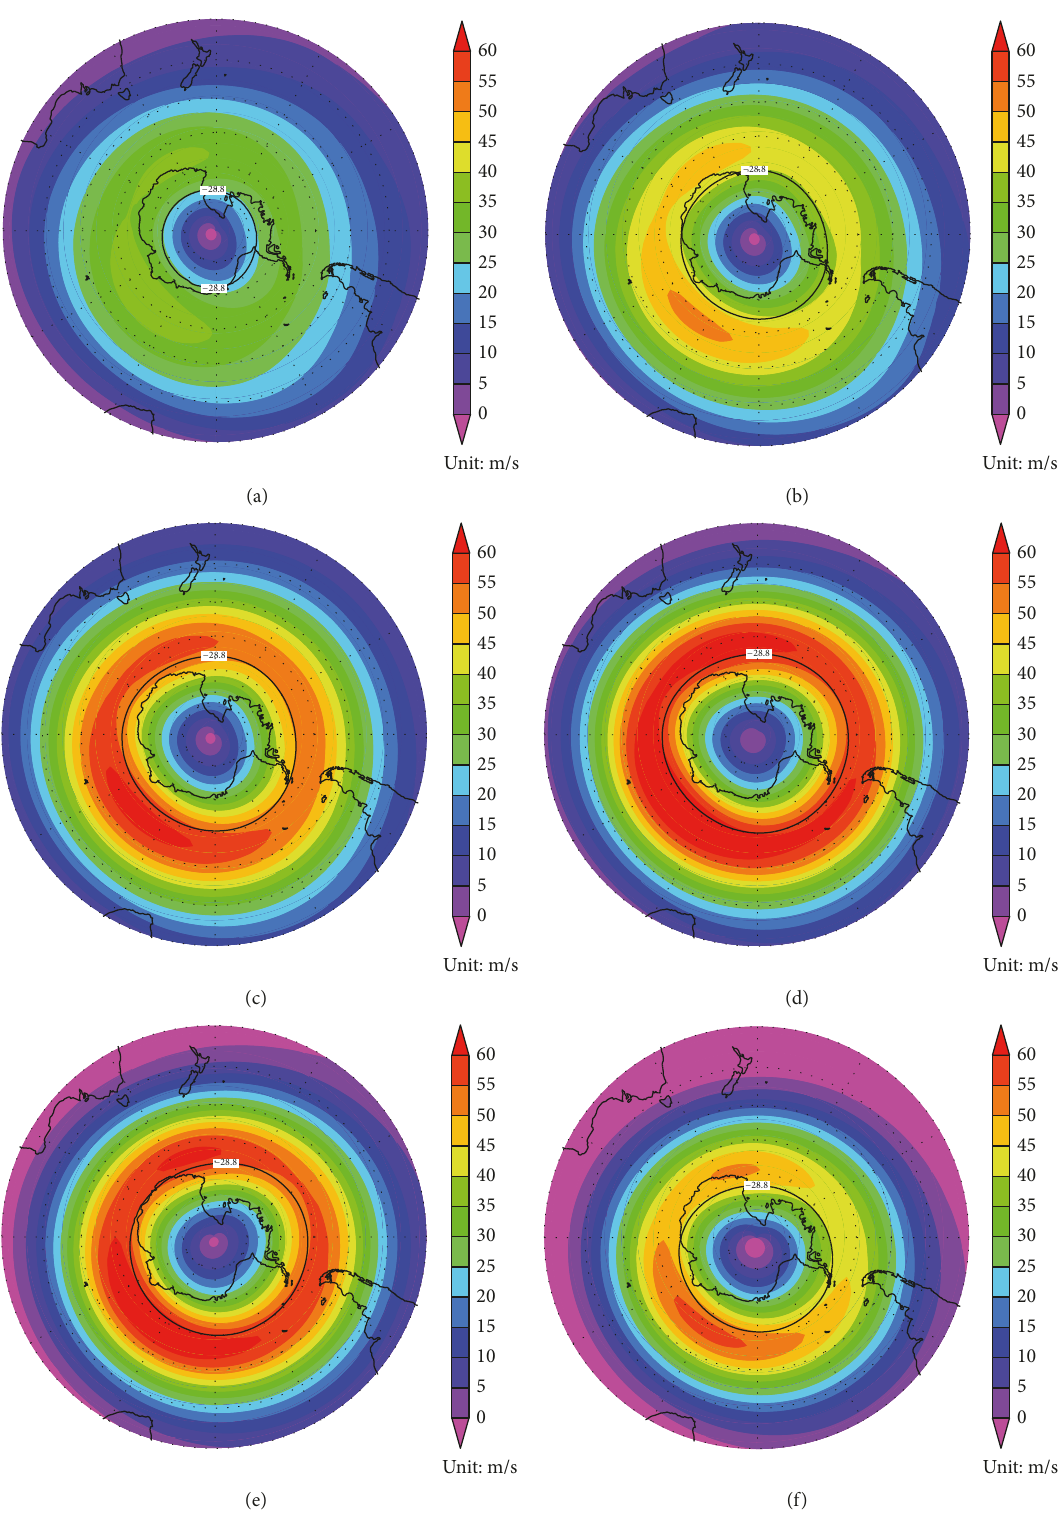
Figure 2: Spatial distributions of the 38-year (1979–2016) zonal wind (units: m/s) climatology on 550 K isentropic surface in (a) May, (b) June, (c) July, (d) August, (e) September, and (f) October. The black solid based on criterion PV contour ( − 28.8 PVU) represents the vortex